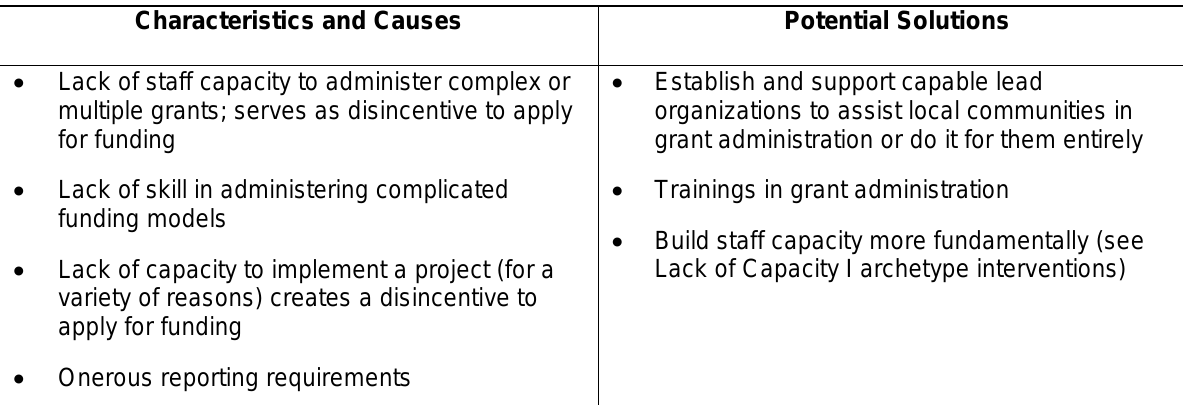
Table A2.16: Characteristics, Underlying Causes and Potential Solutions to